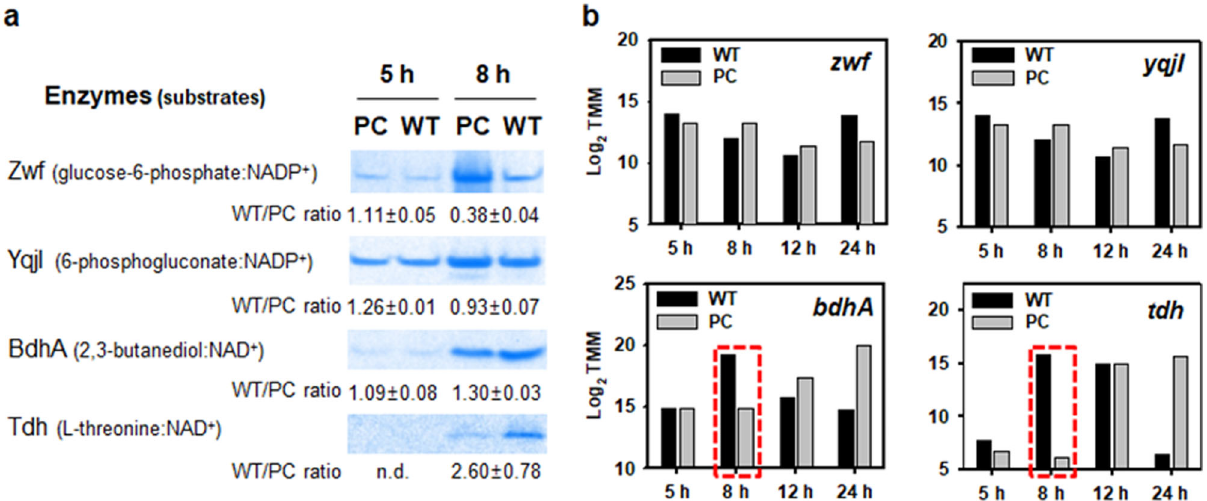
Fig. 10 In-gel activities and gene expression levels of NAD(P)-dependent dehydrogenases. a In-gel activity assays for NAD(P) + -dependent enzymes toward glucose-6-phosphate (Zwf), 6-phophogluconate (YqjI), 2,3-butanediol (BdhA), and L -threonine (Tdh) in whole-cell extracts (20 μ g protein per lane) obtained from early (5 h) and late (8 h) exponential phases of WT and PC cells by non-denaturing blue native polyacrylamide gel electrophoresis. Full images of the blue native gels are shown in Supplementary Fig. 12. b Log 2 transformed mRNA levels show the upregulation of bdhA and tdh expression in the late (8 h) exponential phase of WT cells as highlighted in a red dotted line box (Supplementary Fig.